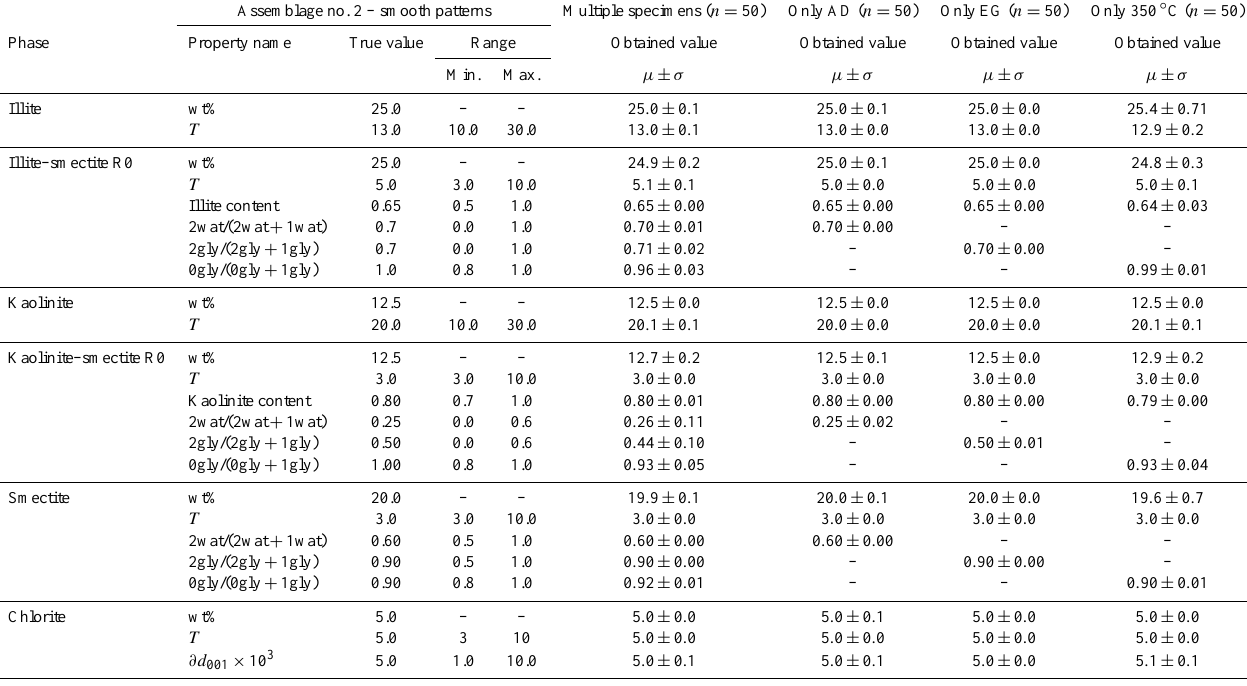
Table 7. Overview of the means and standard deviations of weight fractions and refined parameters for assemblage 2 using smooth patterns. Assemblage no. 2 – smooth patterns